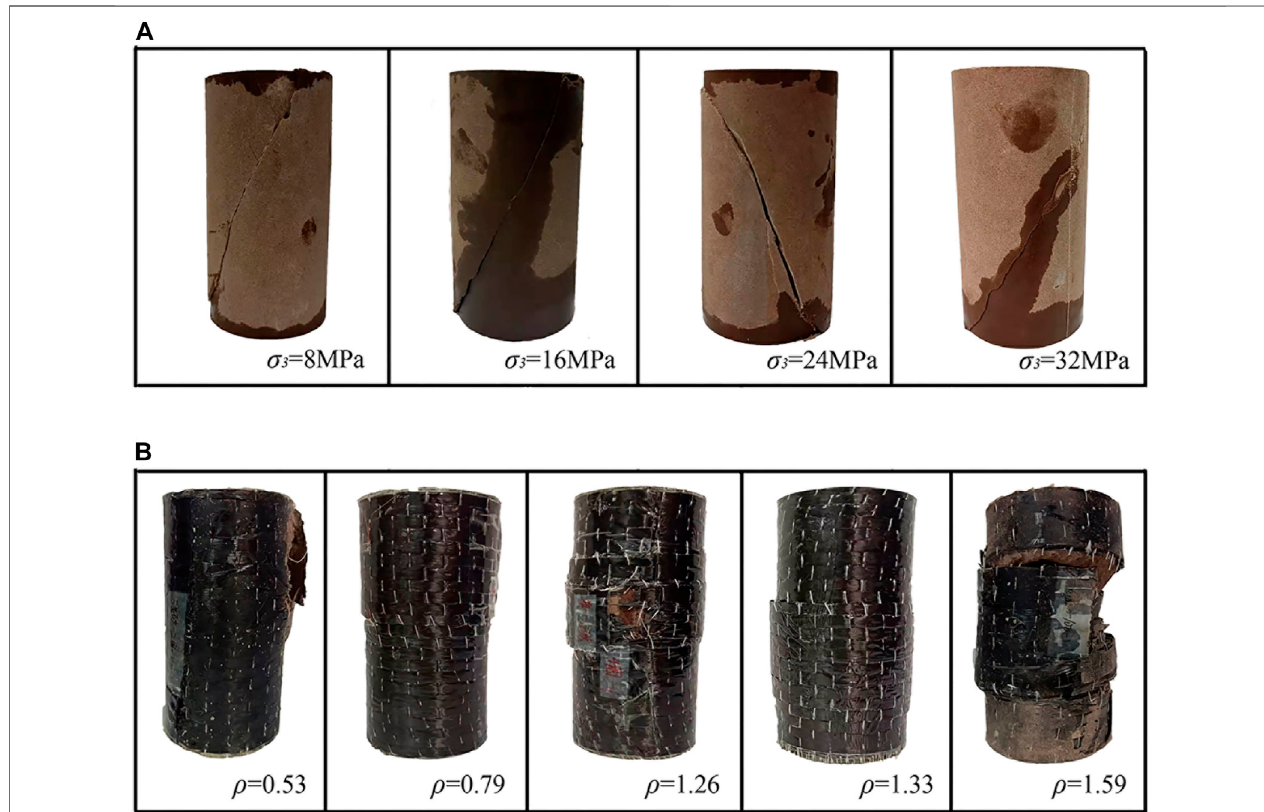
FIGURE 6 | Failure mode of the specimen under different con fi ning conditions. (A) constant con fi ning stress; (B) constant con fi ning stiffness.